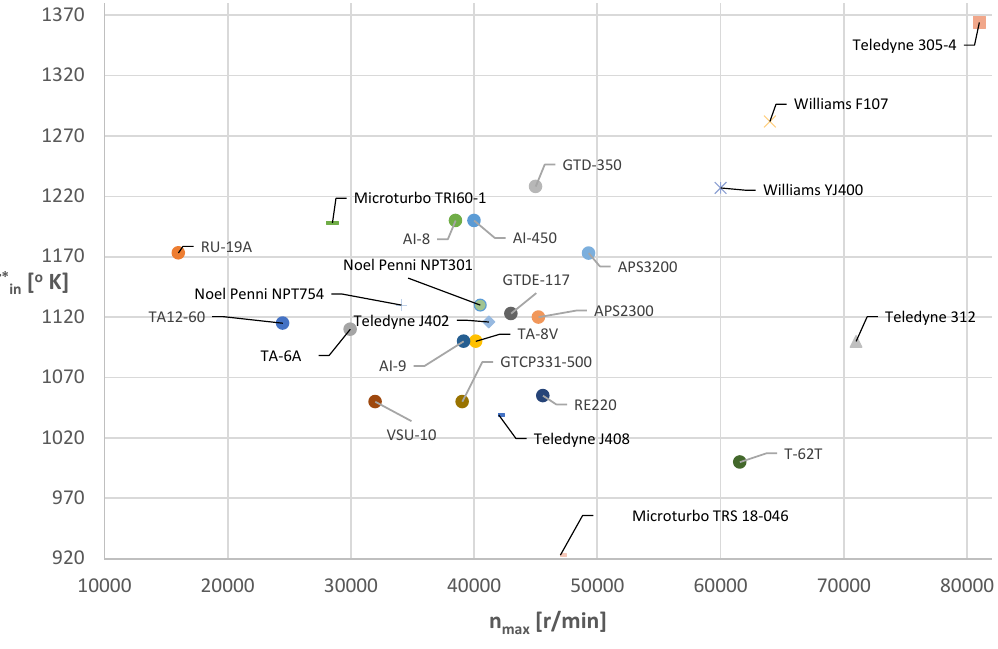
Figure 13. Comparison of the TIT (T *in ) and n max of small turbojet and turboshaft engines.